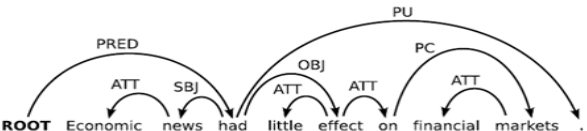
Figure 4. Root/Dependent elements in a sample